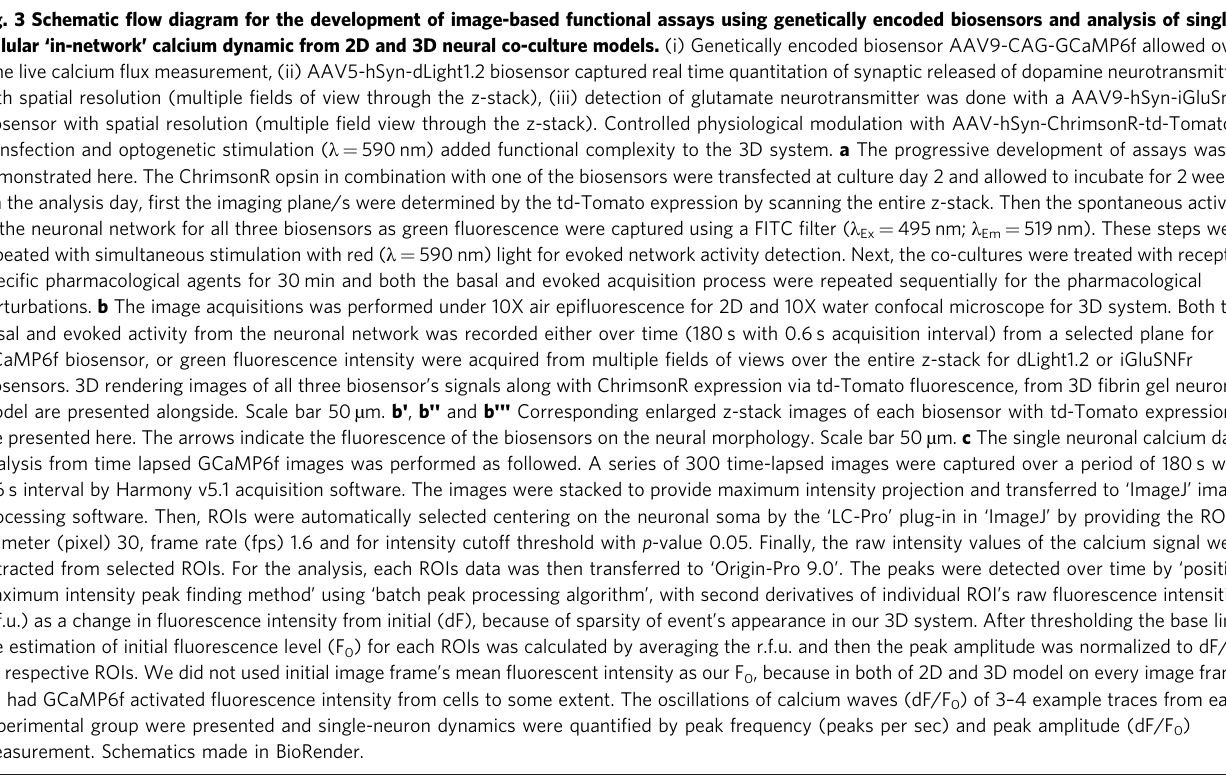
model of iDopas/iAstros co-culture with the different treatments